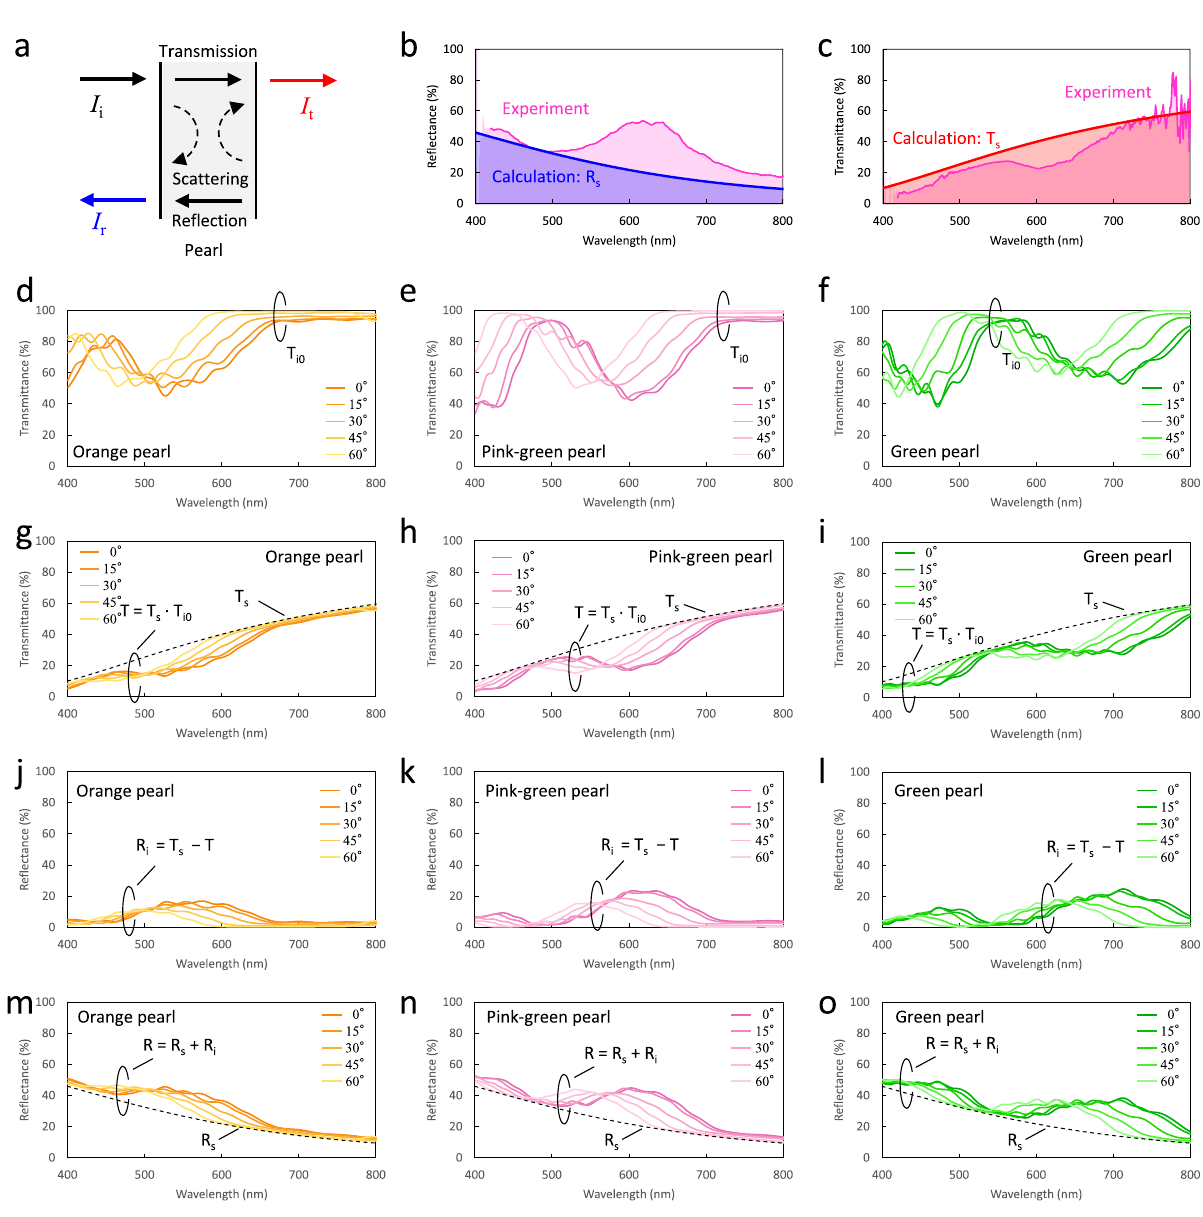
Figure 3. Calculated scattering and interference spectra of three pearls. ( a ) Schematic illustration of approximate model of scattering in pearl. ( b ) Calculated scattering reflection spectrum R s and measured reflection spectrum of pink-green pearl. ( c ) Calculated scattering transmission spectrum T s and measured transmission spectrum of pink-green pearl. ( d – f ) Calculated interference transmission spectra without scattering T i0 of orange, pink-green, and green pearls, respectively. The incident light is P-polarized and the legend represents an incident angle. ( g – i ) Calculated transmission spectra T of pearls obtained by T = T s ∙ T i0 . ( j – l ) Calculated interference reflection spectra R i of pearls. ( m – o ) Calculated reflection spectra R of pearls obtained by R = R s + R i calculations. Since the scattered light in the nucleus passes through the aragonite crystal layers, the transmission spectrum of the pearls T is given by T s ∙ T i0 (Fig. 3g–i). In other words, the scattered light in the nucleus acts as a light source and the aragonite crystal layers function as a transmission color filter. In addition, using the result of the transmission calculation, we can obtain the interference reflection component R i by T s − T (Fig. 3j–l). Since the reflection from the pearls is a superposition of the scattering reflection R s and interference reflection R i , the reflection spectrum R is given by R s + R i (Fig. 3m–o). The reason why the interference reflection R i decreases at shorter wavelengths is that the scattering reflection R s increases at the shorter wavelengths. On the basis of the above procedure, we calculated the reflection and transmission spectra for P- and S-polarizations including the light scattering of the pearls. The calculated reflection and transmission spectra for the orange, pink-green, and green pearls at normal incidence (Fig. 4a–f) show good agreement with the experimental results (Fig. 2c–h).